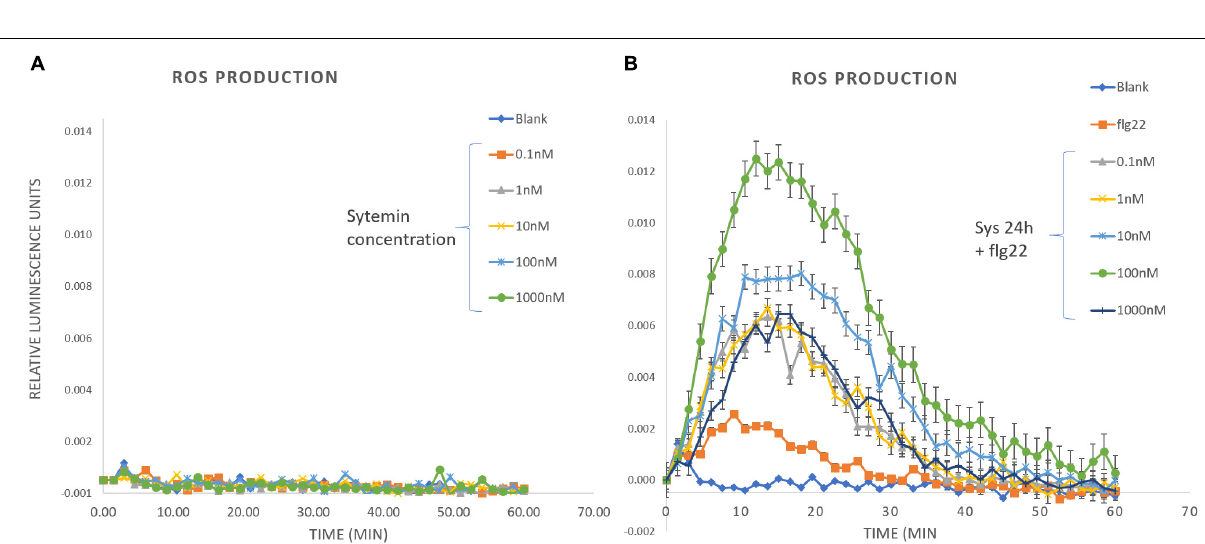
FIGURE 7 | ROS production in response to Systemin and PAMP challenge. H 2 O 2 production was measured during 1 h in leaf disks after elicitation with (A) Systemin at different concentrations and (B) 100 nM flg22 in leaf disks that were pre-treated for 24 h with different concentrations of Systemin. Luminescence was expressed in Relative Luminescence Units. Slopes represent the means of each time-point ± standard error (SD), n =